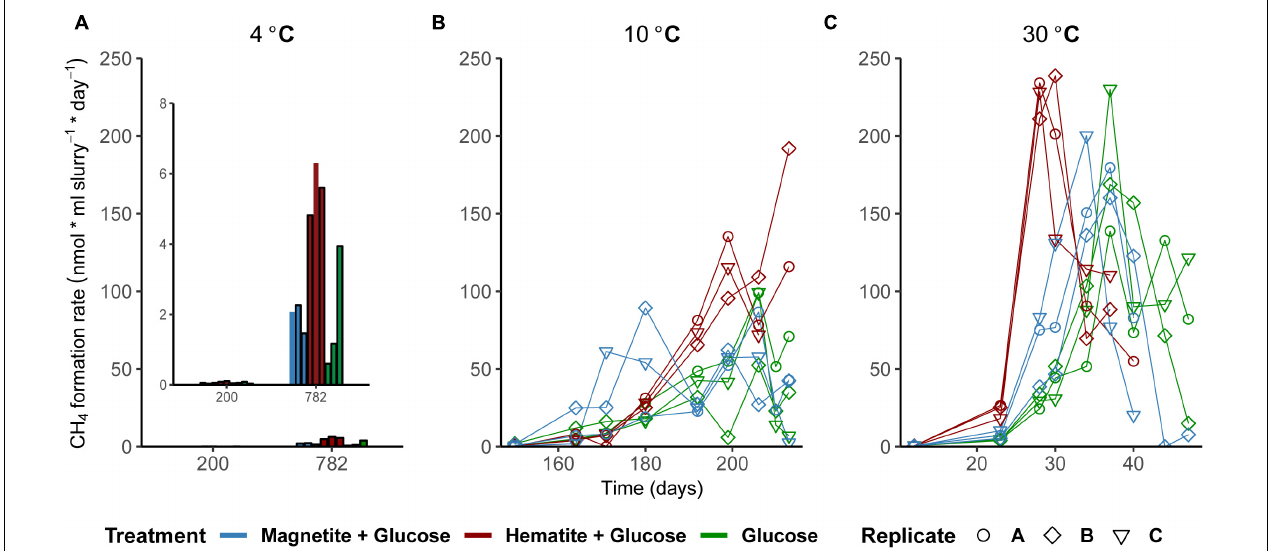
FIGURE 3 | Effect of crystalline iron minerals on methane formation in sediment incubations. Methane formation rates at 4 ◦ C (A) , 10 ◦ C (B) , and 30 ◦ C (C) . Bar plots were displayed for methane formation rates at 4 ◦ C because fewer time-points were measured ( Figure 1D ).